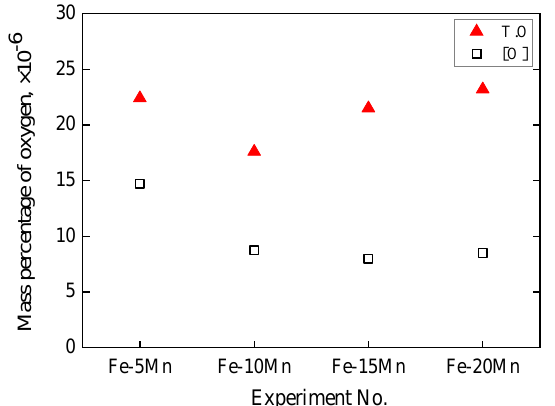
Figure 8. T.O and [O] content of steel.